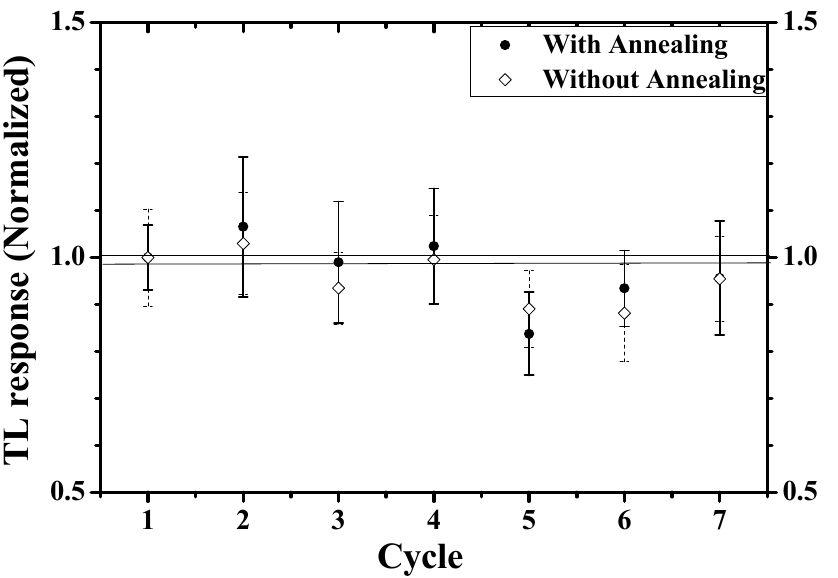
Figure 11. Reproducibility of MgB 4 O 7 :Zn glass S35654.